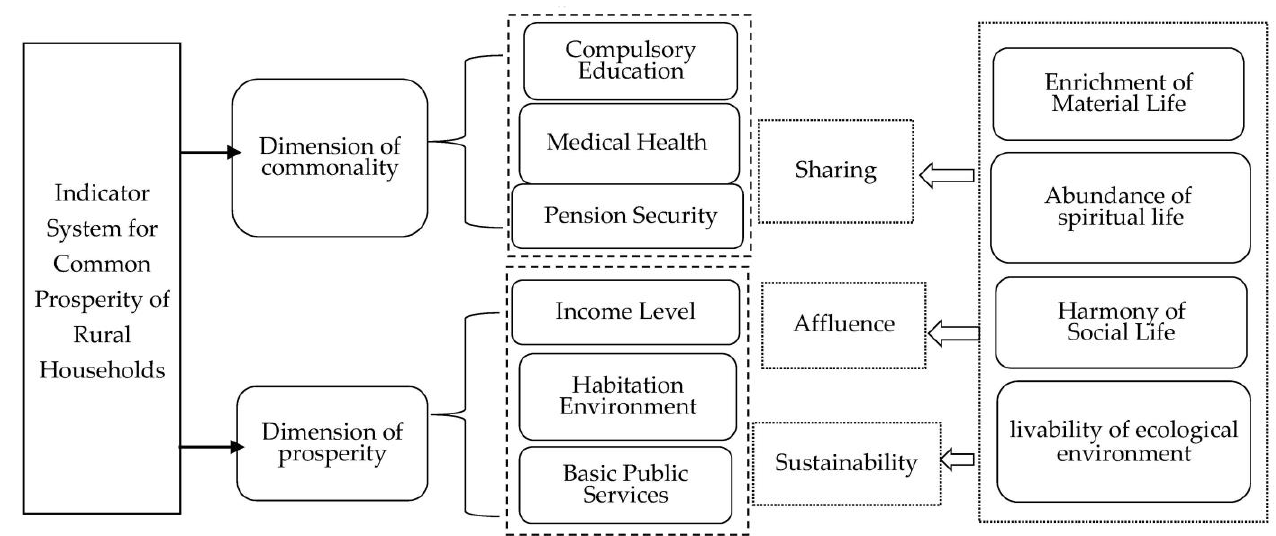
Figure 2. Analysis framework of common prosperity of rural families in China.